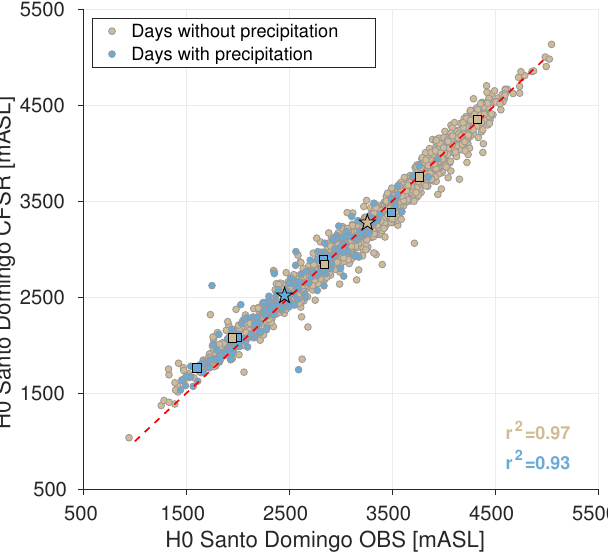
Figure 3. Scatter plot between daily mean values of H 0 observed in Santo Domingo (33.65 ◦ S–71.61 ◦ W, sounding station) and H 0 from the closest grid point in the CFSR reanalysis (33.50 ◦ S–71.50 ◦ W) for days with (blue dots) and without (brown dots) precipitation at Santo Domingo. Stars and squares represent the mean and percentiles (5th, 25th, 75th and 95th) for each distribution. The dashed red line is the 1:1 line. Data from 1999 to